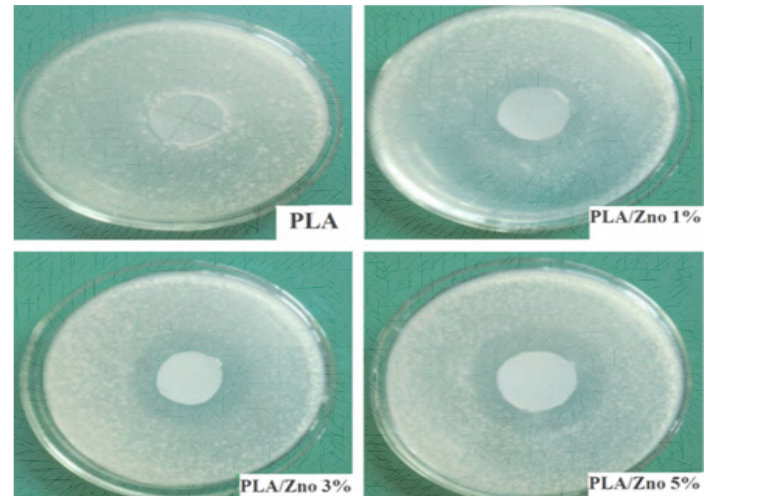
Fig. 2. The inhibitory effect of poly-lactic acids containing nano-zinc oxide on S. aureus